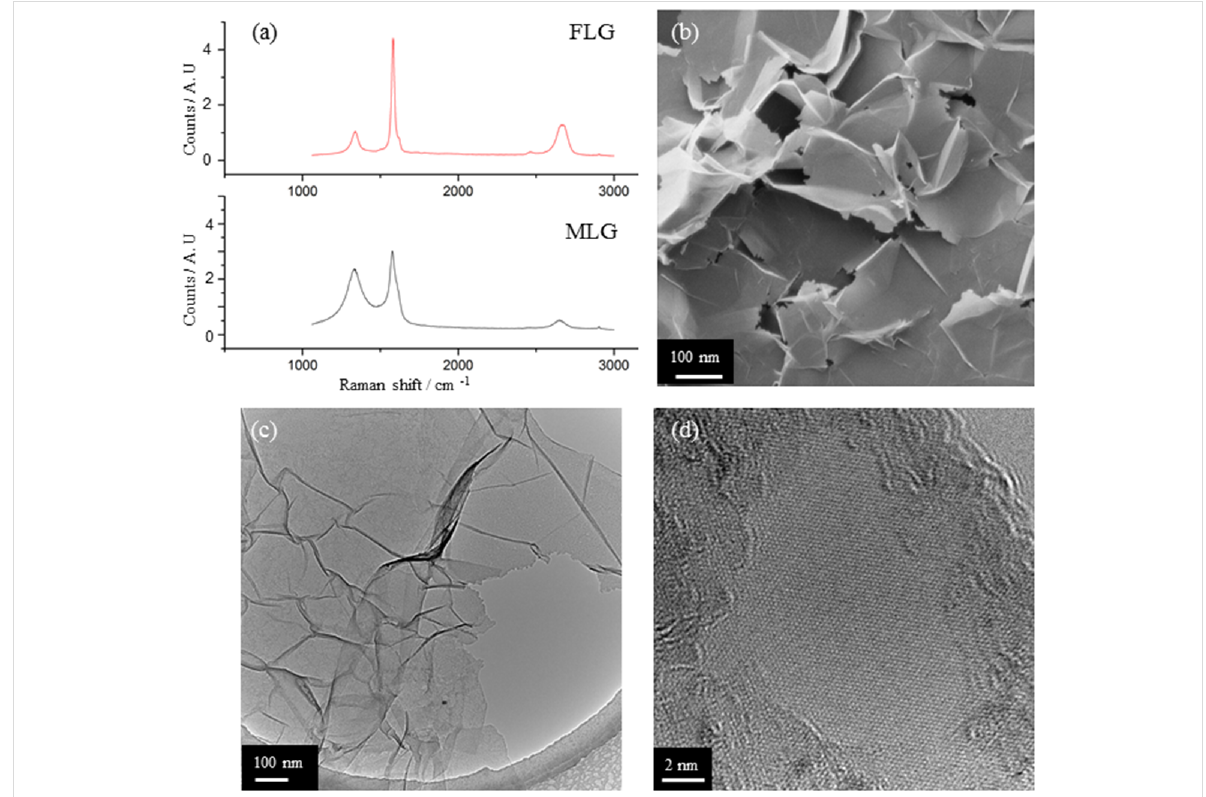
Figure 1: a) Raman spectra of MLG (ca. 10 layers, lower) and FLG (1–6 layers, upper) – both at 514 nm. b) Helium ion microscope (HeIM) overview of FLG, c) TEM overview of FLG and d) HRTEM detail of FLG showing a single layer.